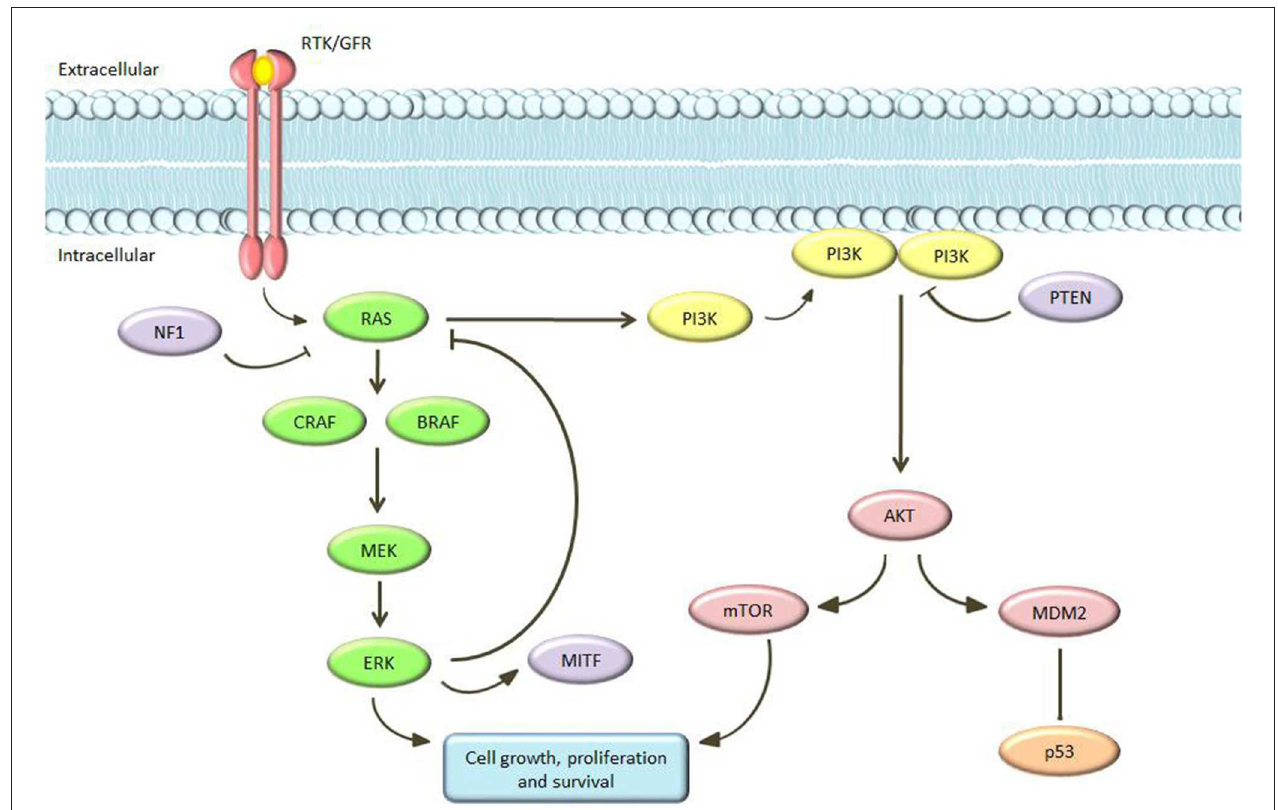
FIGURE 1 | Schematic view of the MAPK and PI3K pathways.